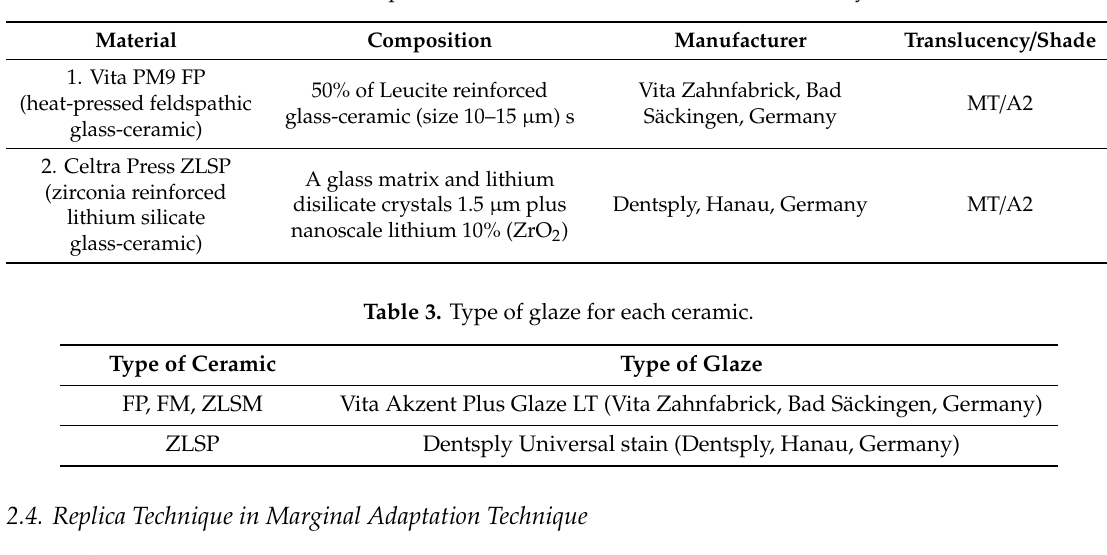
Table 2. Heat-pressed ceramic materials included in this study.